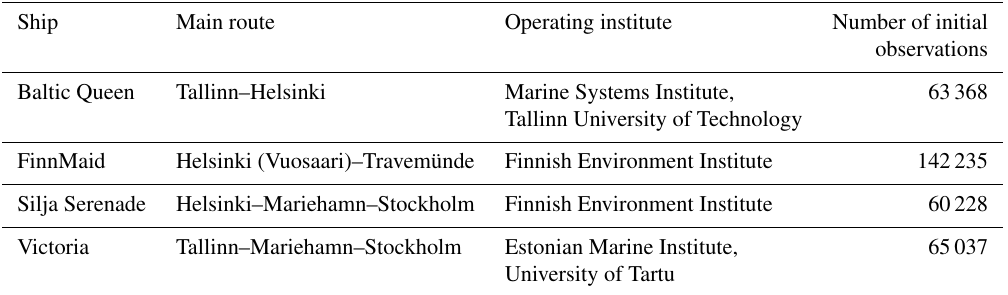
Table 1. FerryBox data from 1 May to 31 December 2015 in the NE Baltic used in the present study.